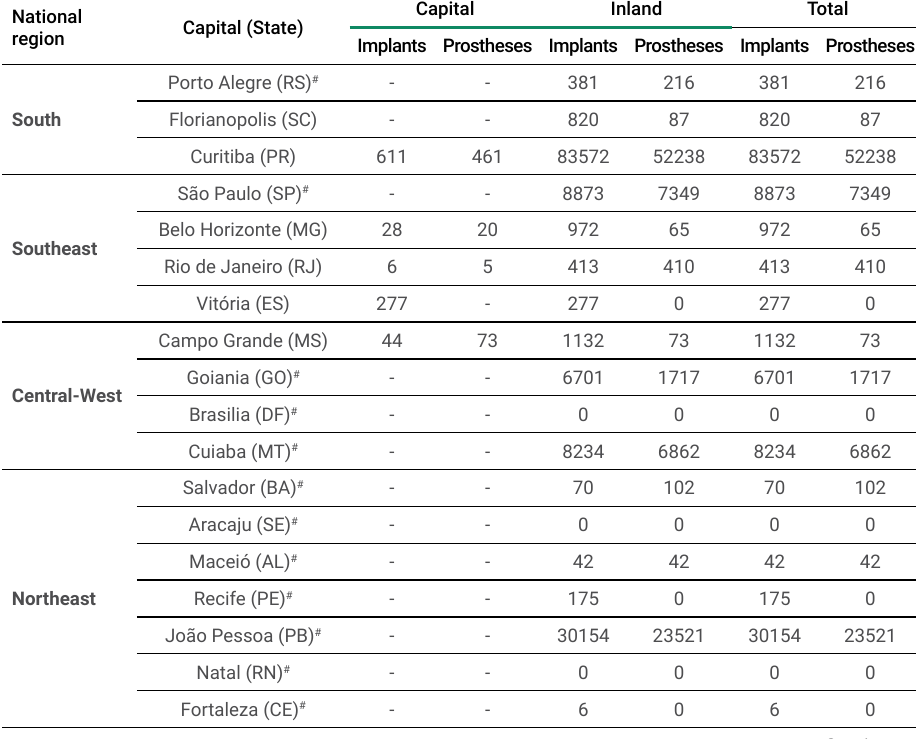
Table 2. Comparison of implant-related treatments provided by SUS in capitals or inland cities of Brazil (number of installed dental implants and number of installed dental prosthesis: DATASUS*; January 2010 to December 2019)